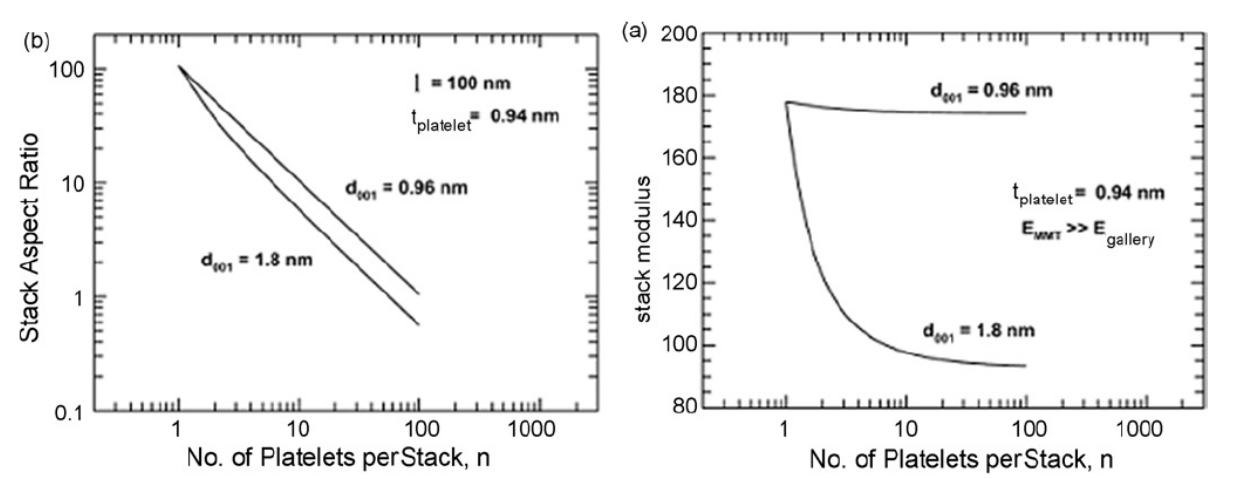
Figure 28. Stack aspect ratio as well as stack modulus as a function of the number of platelets in the stack. Reproduced from reference [134] with permission from